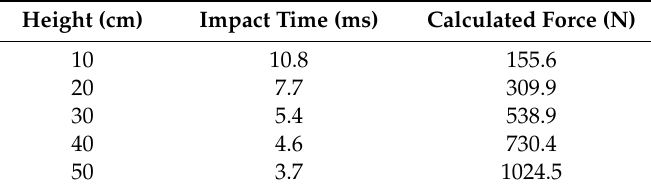
Table 3. Conversion between height and impact